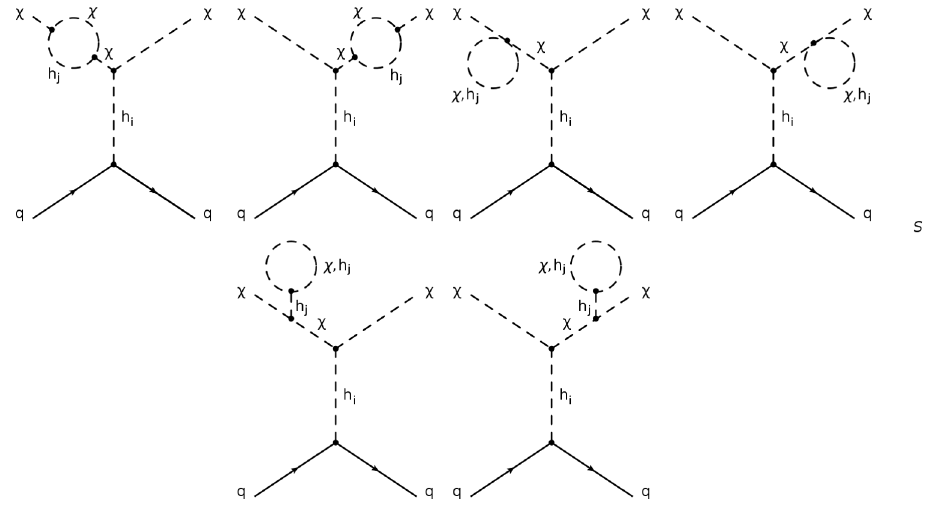
Figure 3 . External leg corrections to the DM-nucleon scattering with i, j, k ∈ { 1 , 2 , 3 }